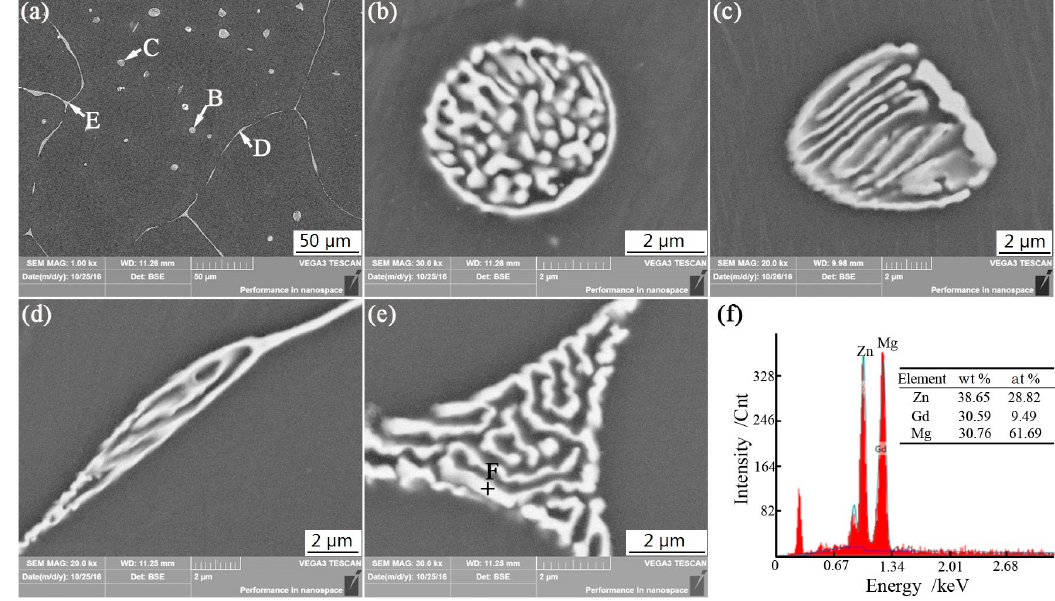
Figure 2 . Microstructure of 3Gd alloy: ( a ) lower magnification; ( b – e ) higher magnifications of secondary phases; ( f ) results of EDS.